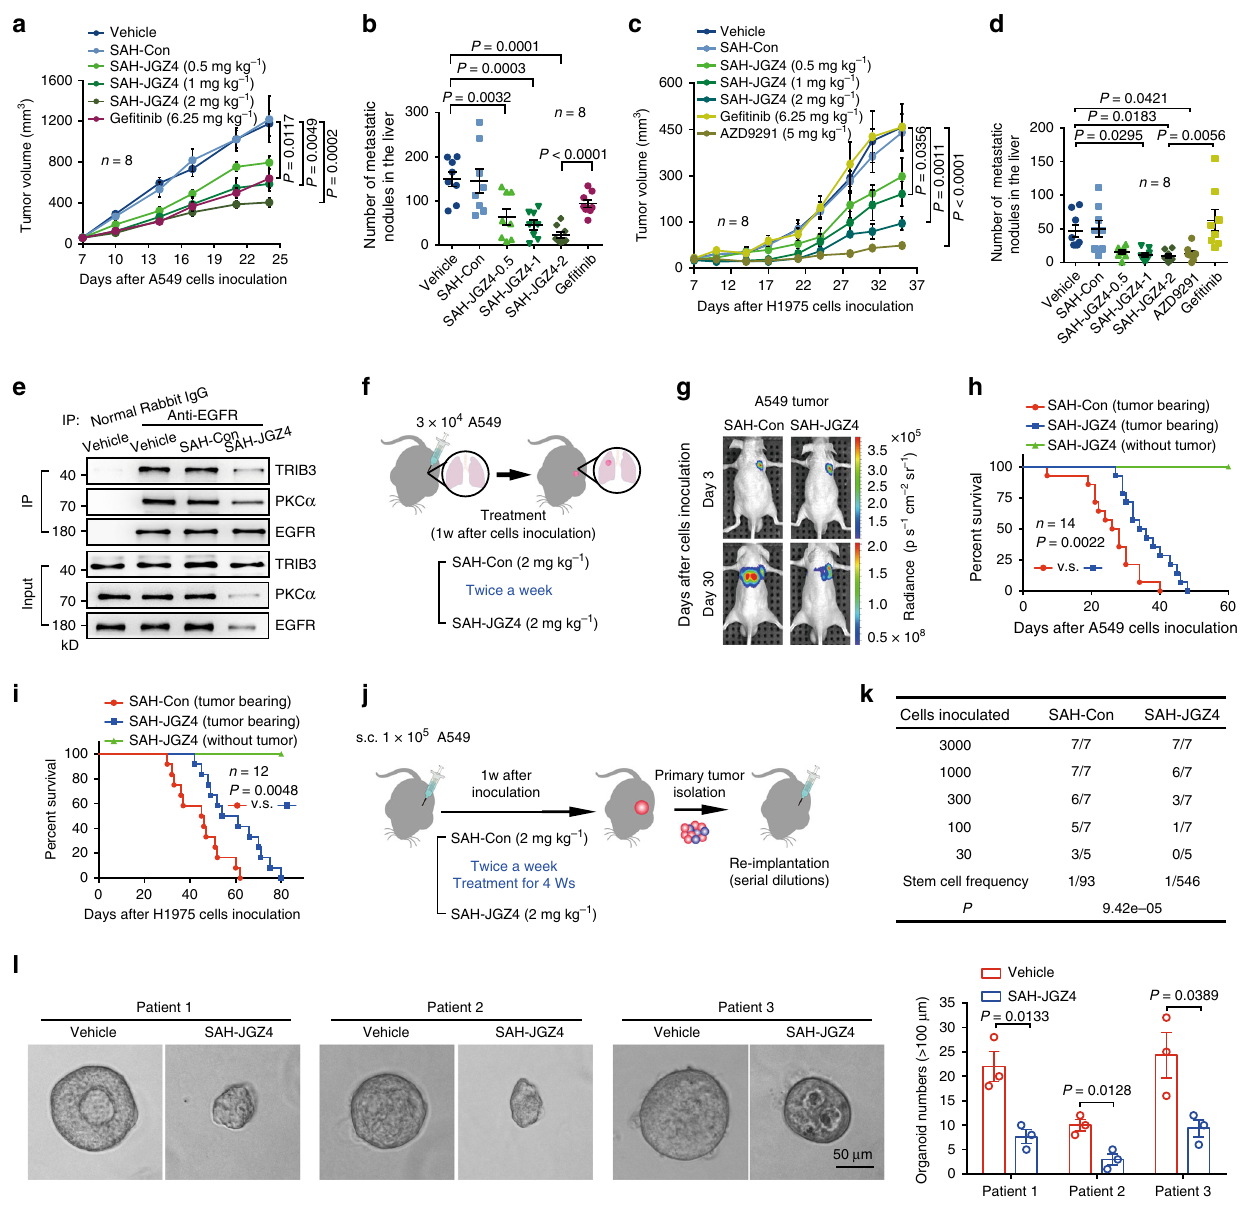
Fig. 7 Targeting EGFR stability inhibits lung cancer initiation and progression. a A549 tumor growth curves under different treatment. b Quantitative analysis of metastatic nodule numbers from mice as described in a . c NCI-H1975 tumor growth curves under different treatment. d Quantitative analysis of metastatic nodule numbers from mice as described in c . Data in a – d are presented as means ± SEM, n = 8. e The EGFR – TRIB3 or EGFR – PKC α interaction in xenograft tumors from indicated mice were detected with CO-IP assays. Data are representatives of three assays. f Generation of orthotopic xenograft lung cancer model for investigating in vivo antitumor activity of SAH-JGZ4. g Representatives of bioluminescence images of orthotopic lung implanted mice at indicated times. h Survival curves for mice orthotopically lung implanted with A549 cells under indicated treatment. Statistical difference was determined by two-sided log-rank test, n = 14. i Survival curves for mice orthotopically lung implanted with NCI-H1975 cells under indicated treatment. Statistical difference was determined by two-sided log-rank test, n = 12. j Strategy for the evaluation of SAH-JGZ4 on tumor initiation capacity in vivo. k Frequency of tumorigenic cell and probability estimates were calculated according to Poisson statistics with the use of Extreme Limiting Dilution Analysis (ELDA) online software (http://bioinf.wehi.edu.au/software/elda/). The P indicates a statistically signi fi cant difference in TIC frequency between SAH-con or SAH-JGZ4. l Images of the patient-derived lung cancer organoids in 3D culture following vehicle or SAH-JGZ4 (5 μ M) treatment for 7 days. Data are means ± SEM of three independent assays. Statistical signi fi cance between two groups was determined with two-tailed Student ’ s t test. Statistical signi fi cance among groups was determined by one-way ANOVA test. Source data are provided as a Source Data fi